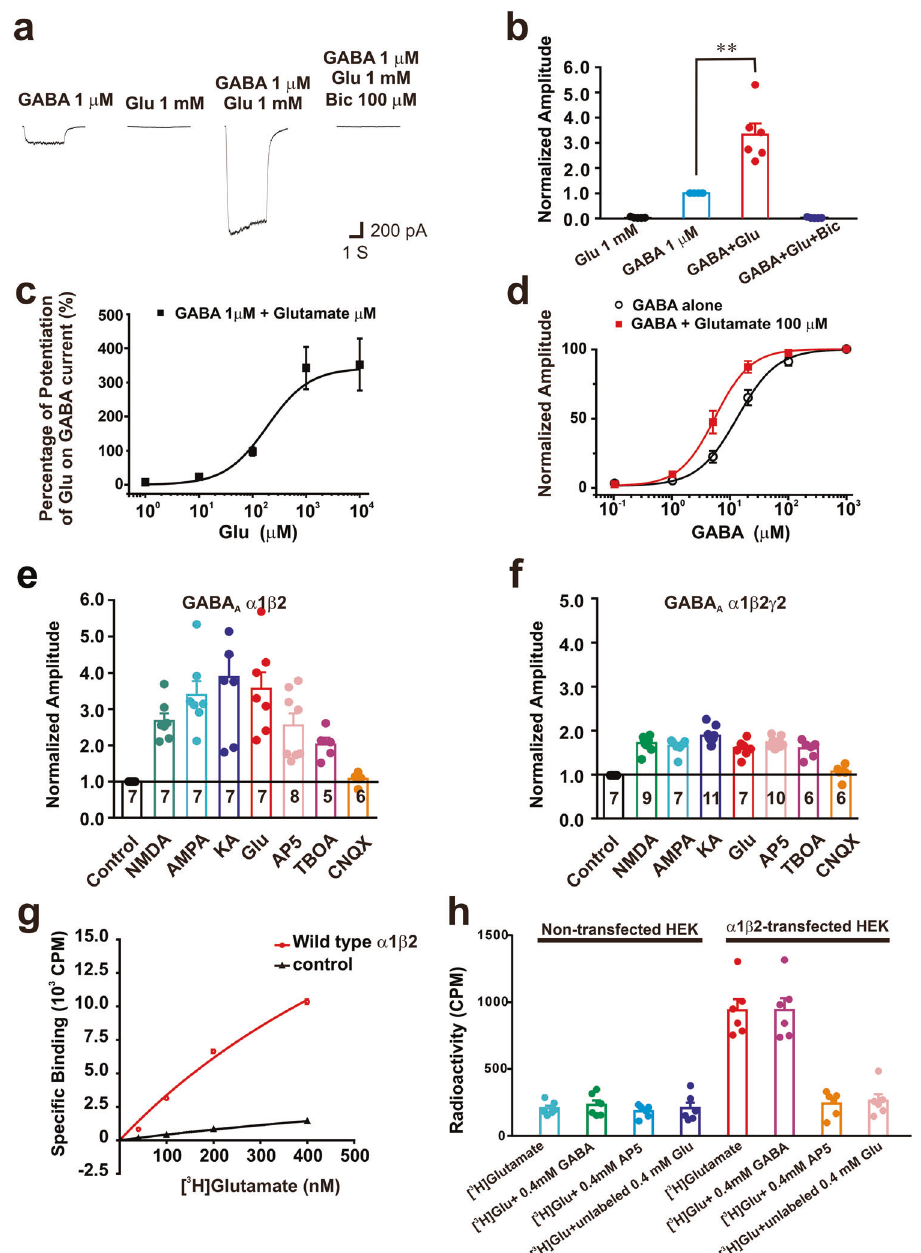
Fig. 1 Glutamate-like ligands potentiate GABA A R-mediated currents via a direct binding to the receptor in HEK293 cells. HEK293 cells were transiently transfected with rat GABA A R α 1/ β 2 ( a – e ) or α 1/ β 2/ γ 2 ( f ) subunits. Whole-cell voltage-clamp recordings were performed with a chloride- based intracellular recording solution at a holding membrane potential of − 60mV. GABA A R-mediated currents were evoked by perfusion of GABA alone and/or in combination with a glutamate-like ligand through a computer-driven multi-barrel fast perfusion system. a Representative traces showing that glutamate potentiated GABA A R-mediated currents. Glutamate (1 mM) produced no detectable currents on its own, but potentiated GABA currents; these currents were blocked by bicuculline (100 μ M). b Bar graph summarizing glutamate potentiation of GABA A R mediated currents from six individual cells shown in a . c Dose-response curve showing glutamate – induced potentiation of the currents evoked by 1 μ M GABA ( n = 7). d GABA dose-response curves constructed from currents recorded in the presence and absence of 100 μ M glutamate showing the glutamate-induced left shifting of GABA dose-response curve. e , f Bar graphs summarizing the potentiation of GABA (1 μ M)-induced currents by glutamate or its analogs in HEK293 cells expressing α 1/ β 2 ( e ) or α 1/ β 2/ γ 2 ( f ) GABA A Rs (Numbers in each bars in e and f indicate the number of independent recording in each groups). g , h Glutamate binds to the α 1/ β 2 GABA A Rs via a site that is not overlapped with the GABA binding site. [ 3 H]glutamate binding assays showed glutamate speci fi cally bound to the plasma membranes of HEK293 transiently transfected with α 1 β 2 GABA A Rs, but not that of non-transfected HEK293 controls ( g ; n = 3). The speci fi c [ 3 H]glutamate (40nM) binding was competitively blocked by a high concentration of non-radiolabeled glutamate or AP5, but not affected by a high concentration of non-radiolabeled GABA ( h ; n =